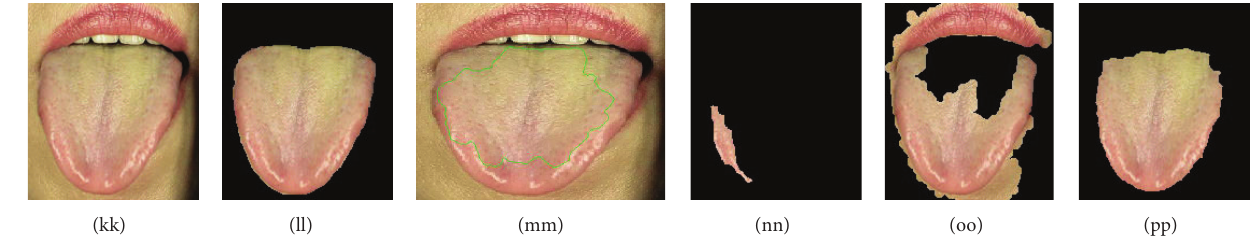
Figure 9: Result comparisons of 4 kinds of tongue image extraction methods. (a) Light red tongue image. (b) Manual segmentation result of light red tongue. (c) Segmentation result of light red tongue image by geodesic active contour. (d) Extraction result of light red tongue by the method mentioned in [21]. (e) Extraction result of light red tongue by the method mentioned in [22]. (f) Extraction result of light red tongue by our method. (g) Light white tongue image. (h) Manual segmentation result of light white tongue. (i) Segmentation result of light white tongue by geodesic active contour. (j) Extraction result of light white tongue by the method mentioned in [21]. (k) Extraction result of light white tongue by the method mentioned in [22]. (l) Extraction result of light white tongue by our method. (m) Red tongue image. (n) Manual segmentation result of red tongue. (o) Segmentation result of red tongue by geodesic active contour. (p) Extraction result of red tongue by the method mentioned in [21]. (q) Extraction result of red tongue by the method mentioned in [22]. (r) Extraction result of red tongue by our method. (s) Deep red tongue image. (t) Manual segmentation result of deep red tongue. (u) Segmentation result of deep red tongue by geodesic active contour. (v) Extraction result of deep red tongue by the method mentioned in [21]. (w) Extraction result of deep red tongue by the method mentioned in [22]. (x) Extraction result of deep red tongue by our method. (y) Purple tongue image. (z) Manual segmentation result of purple tongue. (aa) Segmentation result of purple tongue by geodesic active contour. (bb) Extraction result of purple tongue by the method mentioned in [21]. (cc) Extraction result of purple tongue by the method mentioned in [22]. (dd) Extraction result of purple tongue by our method. (ee) Tongue image with thick white coating. (ff) Manual segmentation result of tongue with thick white coating. (gg) Segmentation result of tongue with thick white coating by geodesic active contour. (hh) Extraction result of tongue with thick white coating by the method mentioned in [21]. (ii) Extraction result of tongue with thick white coating by the method mentioned in [22]. (jj) Extraction result of tongue with thick white coating by our method. (kk) Tongue image with thick yellow coating. (ll) Manual segmentation result of tongue with thick yellow coating. (mm) Segmentation result of tongue with thick yellow coating by geodesic active contour. (nn) Extraction result of tongue with thick yellow coating by the method mentioned in [21]. (oo) Extraction result of tongue with thick yellow coating by the method mentioned in [22]. (pp) Extraction result of tongue with thick yellow coating by our